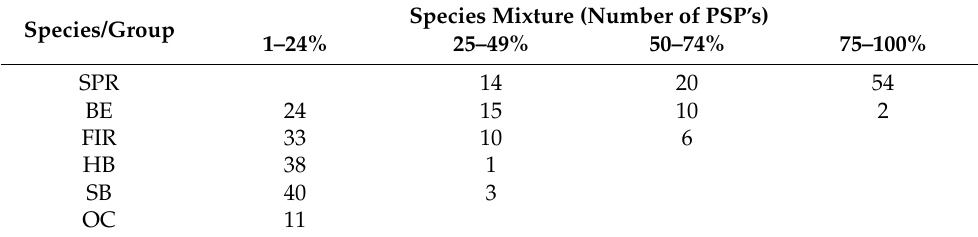
Table 1. Number of PSPs based on the mixture classes. Species/Group